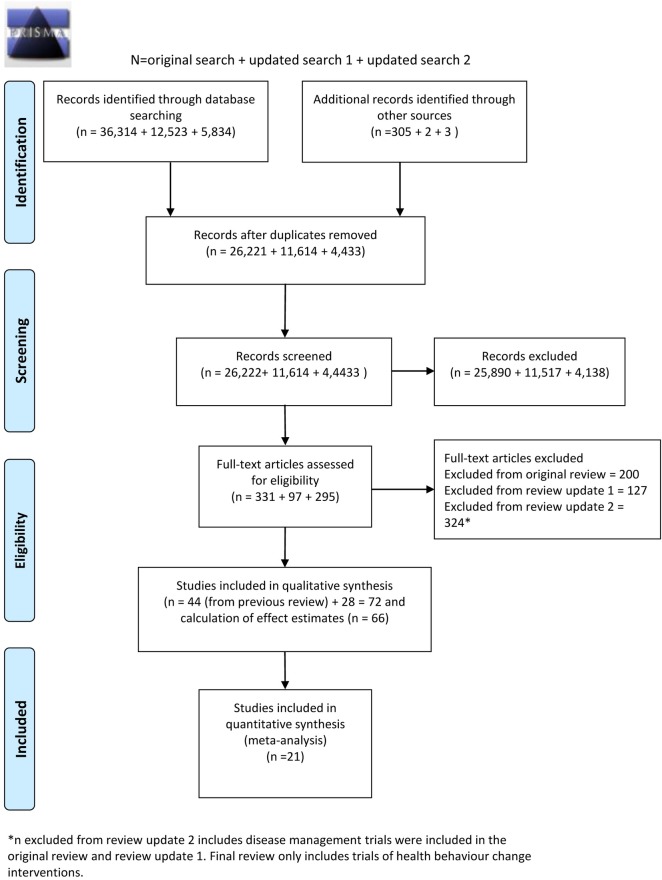
PRISMA flow diagram.